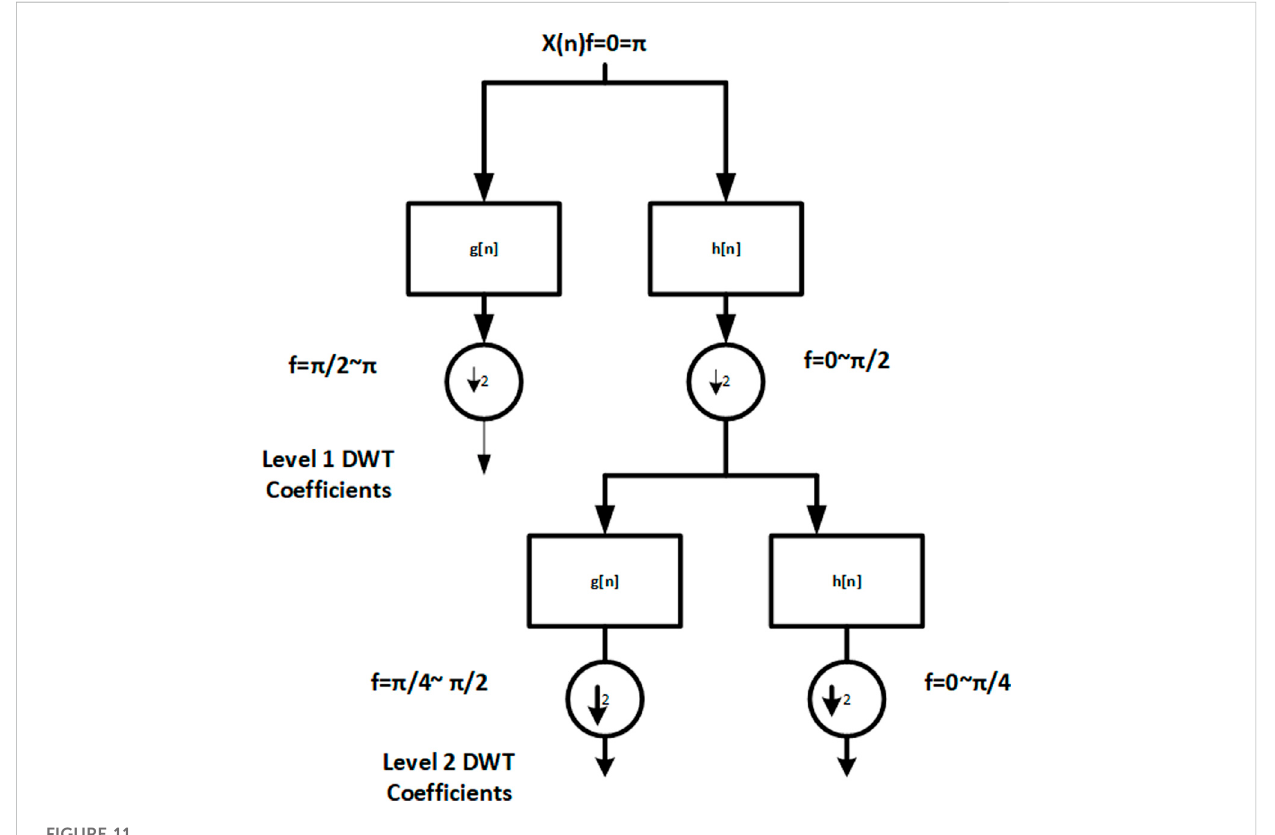
FIGURE 11 DWT decomposition of signal (Daubecheis,